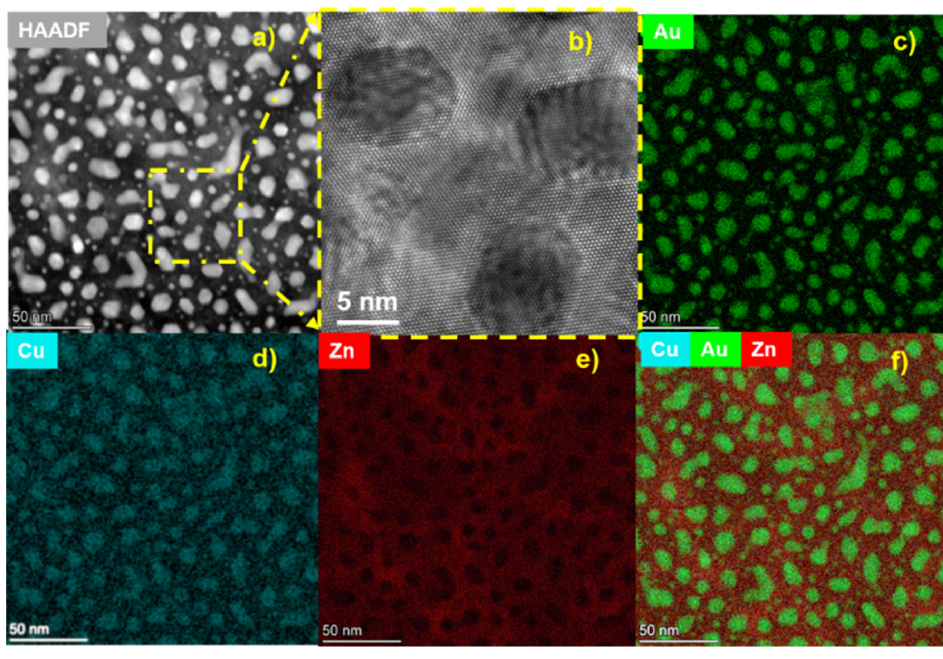
Figure 3. Plan view of ZnO-Au x Cu 1 − x . ( a ) STEM plan view of ZnO-Au x Cu 1 − x , ( b ) high-resolution TEM image of yellow box inset in ( a ). Elemental EDS mapping of ( c ) Au, ( d ) Cu, ( e ) Zn, and ( f ) combined map.